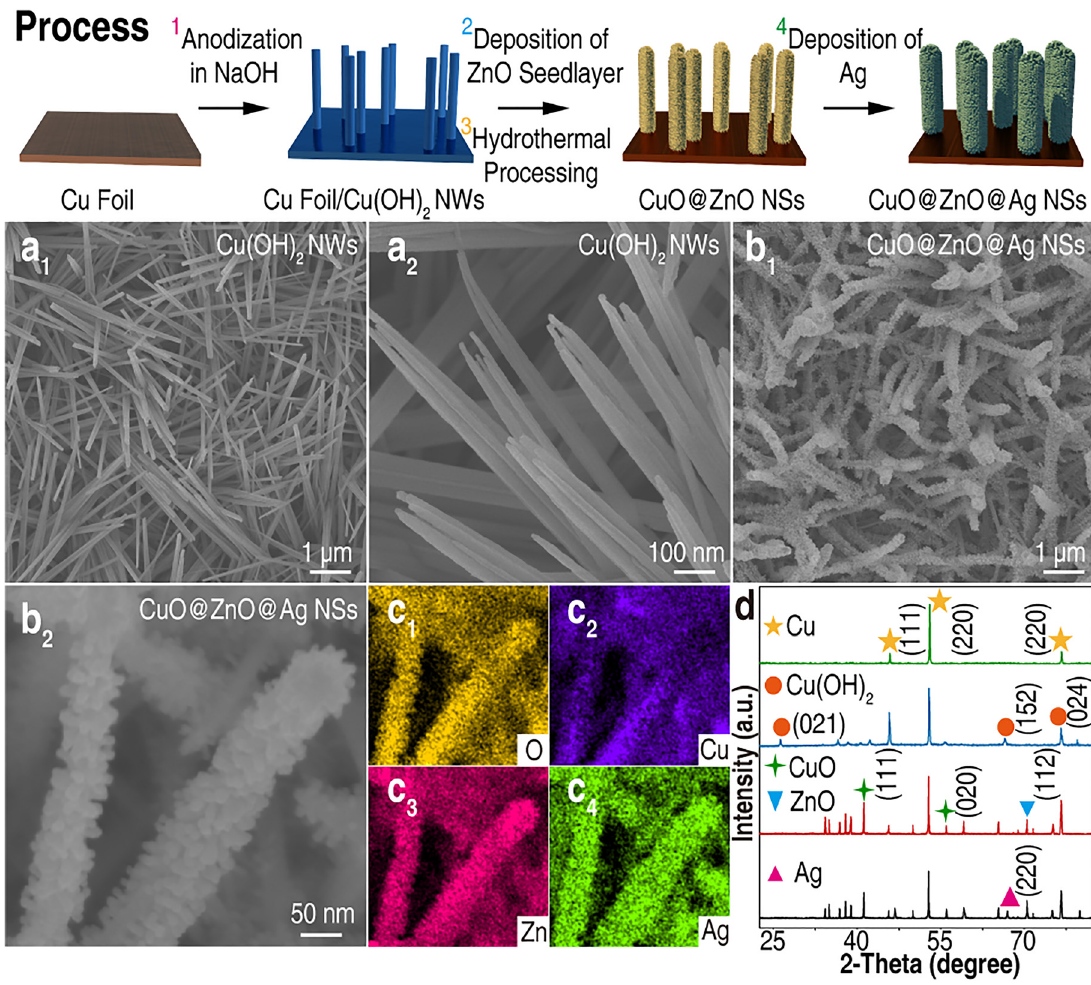
Figure 1: Preparation process of CuO@ZnO@Ag NSs; SEM images of (a 1 , a 2 ) Cu(OH) 2 NWs and (b 1 , b 2 ) CuO@ZnO@Ag NSs; (c 1 – c 4 ) EDS mappings of O, Cu, Zn, and Ag, respectively; and (d) XRD patterns of different samples during the preparation of CuO@ZnO@Ag